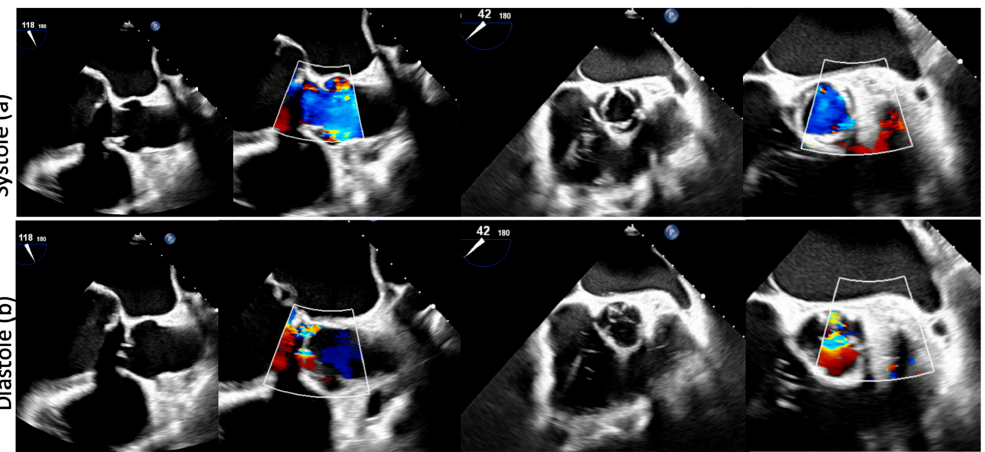
Figure 1. A preoperative transesophageal echocardiogram in systole ( a ) and diastole ( b ) showing annulus dilatation, a large central coaptation defect, severe AR, thin leaflet and absence of annulus and leaflets calcification.